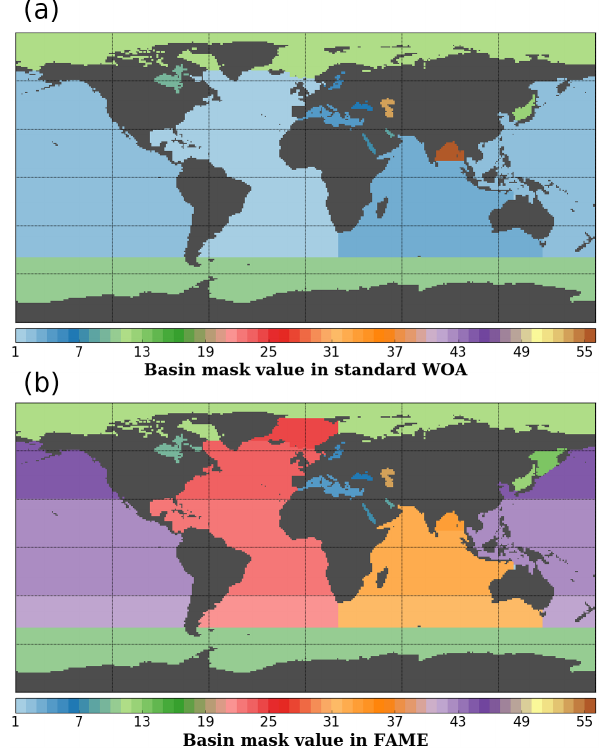
Figure A2. Basin masks as defined in the WOA standard mask file (a) and in FAME (b) on the same 1 ◦ resolution grid. Values correspond to the basins defined in Table